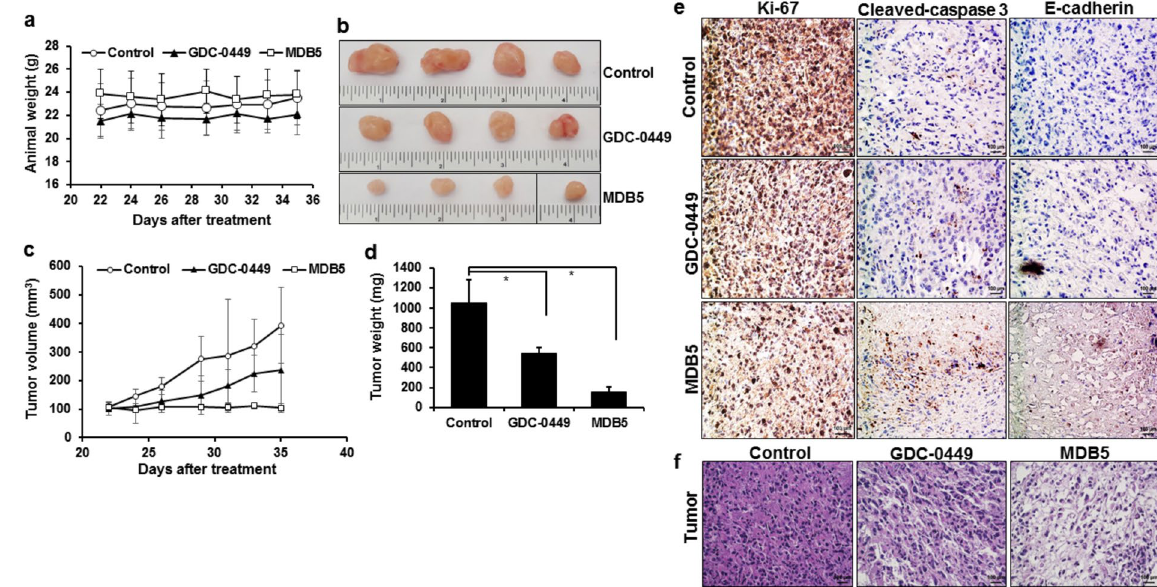
Figure 7. In vivo efficacy of nanoparticles carrying GDC-0449 and MDB5 in tumor bearing mice. ( a ) Animals body weight during treatment. ( b ) Representative tumor size of various treatment groups. (c) Tumor volume. ( d ) Tumor weight. Data are expressed as the mean ± S.E. ( n = 5 ) (Student t-test; * p < 0.05 , n = 5 ). ( e ) Immunohistochemical analysis of tumor samples by Ki-67, Cleaved-caspase 3 and E-cadherin staining. Scale bar, 100 μ m. ( f ) H&E staining of tumor samples. Scale bar, 100 μ m.